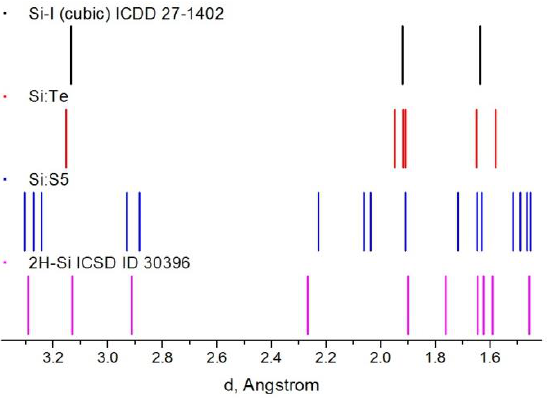
Figure 4. Interplanar distances found in different crystallites of Si:Te (red) and Si:S5 (blue) samples, compared to the literature data for diamond cubic silicon phase (black) and 2H-Si phase (purple).